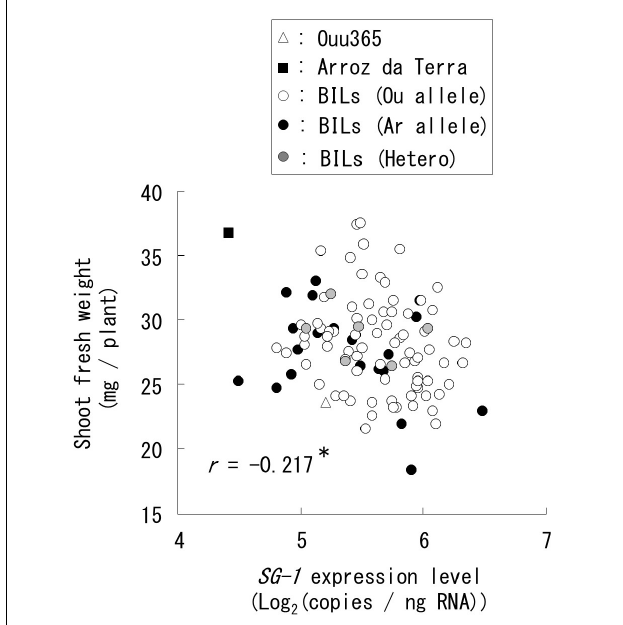
FIGURE 6 | Relationships between short grain 1 ( SG1 ) expression and shoot fresh weight for all the 104 BILs were analyzed by quantitative real-time PCR. Each symbol indicates the mean value of SG1 expression levels and shoot fresh weights in three biological replicates. The shapes and colors of symbols indicate the parental cultivars and BILs that have the Ouu365 (Ou), Arroz da Terra (Ar), or heterozygous (Hetero) alleles in the upstream region ( − 1948 bp) from the translational start site of SG1 . The r -value indicates the correlation coefficient; ∗ P = 0.027 ( n = 104).